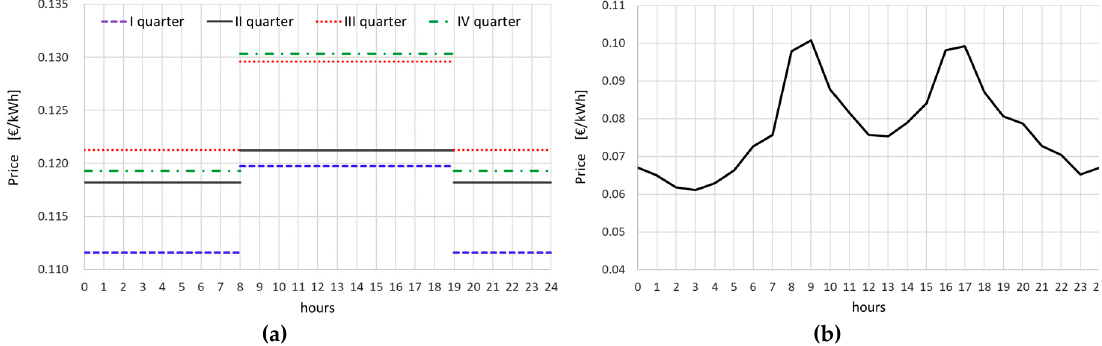
Figure 2. ( a ) Italian electricity time-of-use tariffs for domestic users in 2017. Prices include transport/management and system charges and annual fixed costs, but fees are not included. ( b ) Unique national price (PUN) on a weekday for the year 2017 with the typical double-peak